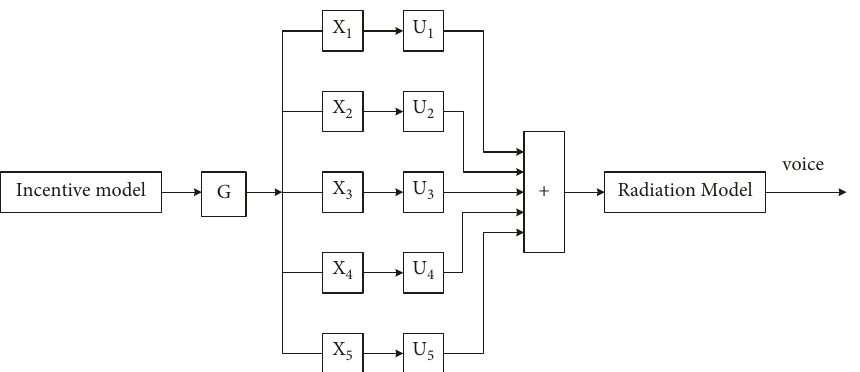
Figure 3: Formant model for parallel